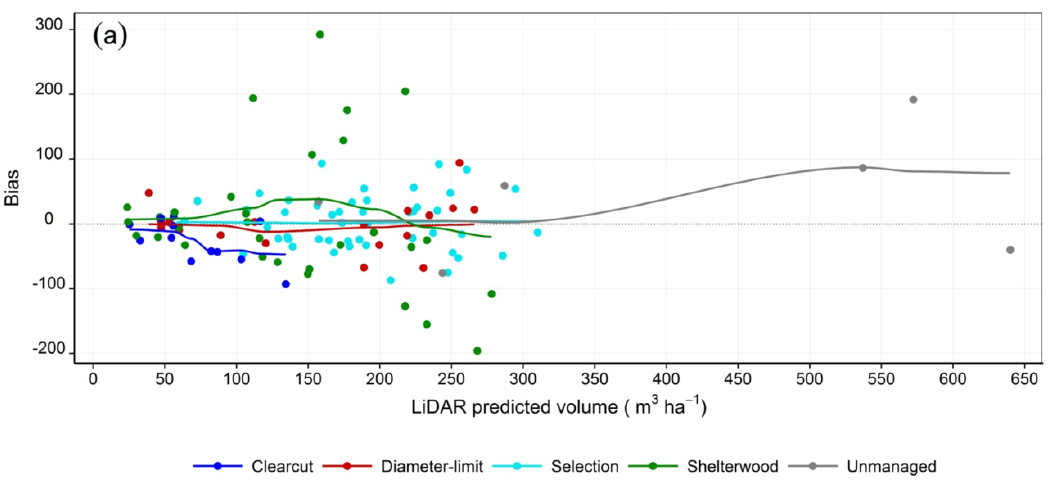
Figure 3. Scatterplot of stem volume prediction bias (observed-predicted; m 3 ha −1 ) over LiDAR predicted values with Lowess regression splines for the different silvicultural treatments ( a) ; and plot species composition based on basal area ( b